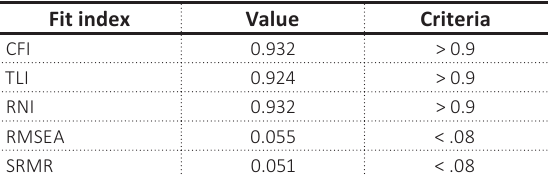
Table 4. Structural model fit indices